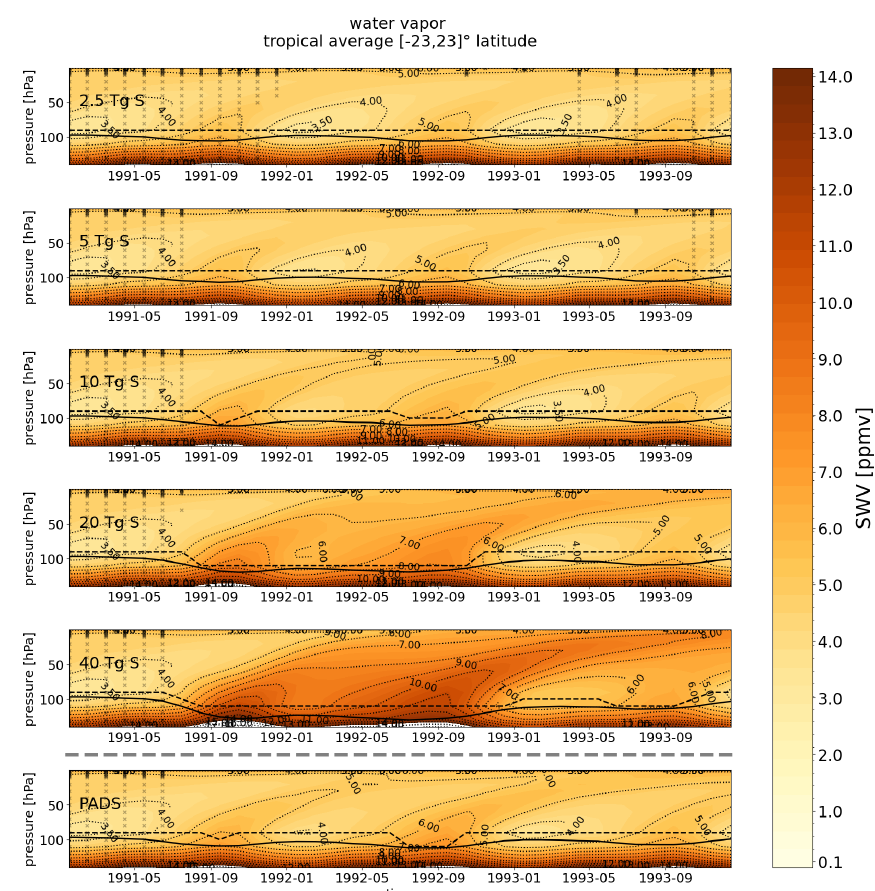
Figure 6. Tropical average in [− 23 , 23 ] ◦ latitude of WV above 140hPa for sulfur injections of 2.5, 5, 10, 20 and 40Tg S as well as the PADS data set. The World Meteorological Organization (WMO)-tropopause pressure is indicated by a black line and the cold-point pressure is denoted by the dashed black line. Absolute values are shown. In regions not covered by black crosses, statistically significant differences between water vapor values of the perturbed and unperturbed runs ( t test at p = 0 . 05) were